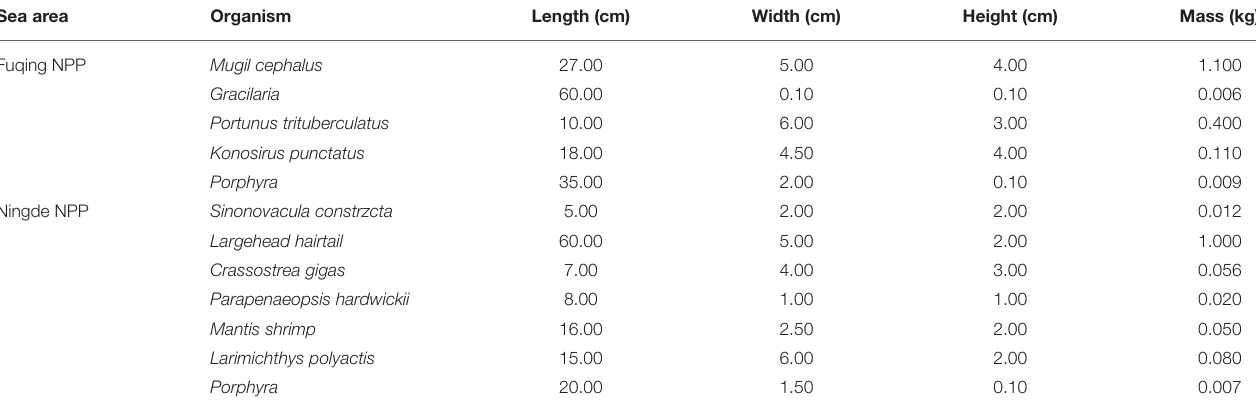
TABLE 1 | Average biological parameters of the sampled marine organisms.